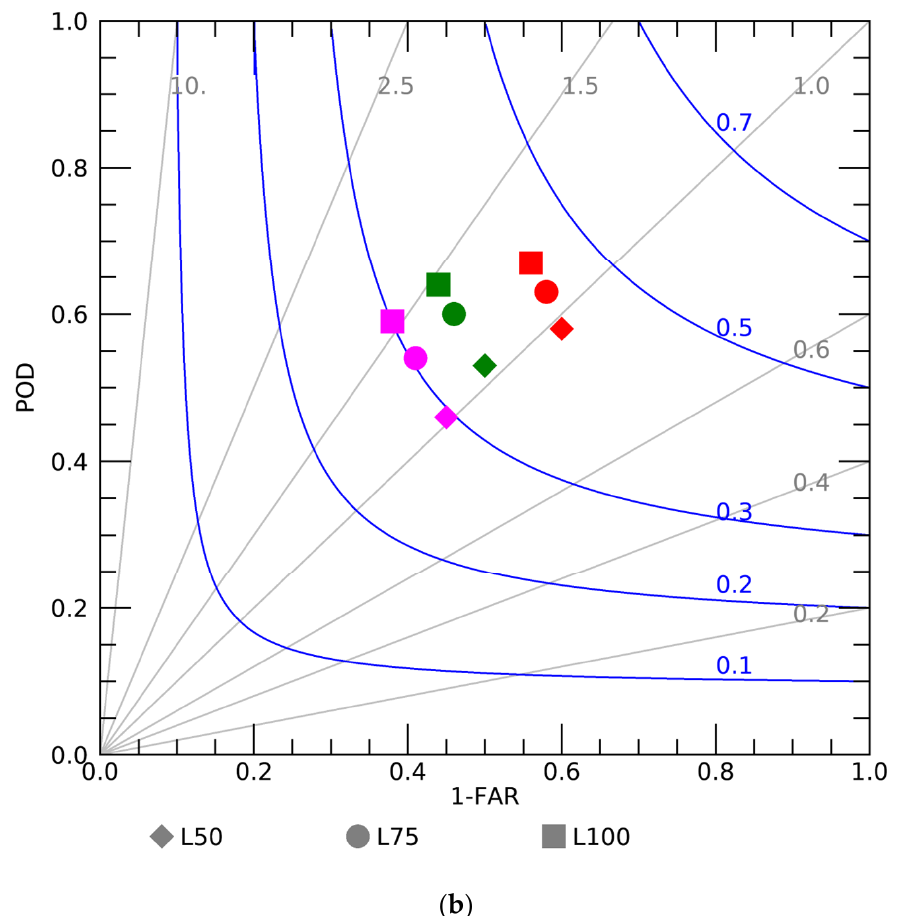
Figure 6. Performance diagram for grid cells of ( a ) 6 km and ( b ) 24 km. L50 is represented by a diamond, L75 is represented by a circle, and L100 by a square. Red symbols are used for 1 stroke per grid cell per day, green symbols for 10 strokes per grid cell per day, and magenta symbols for 30 strokes per grid cell per day. Grey lines indicate FBIAS with values in grey, and blue lines indicate the TS with values in blue.